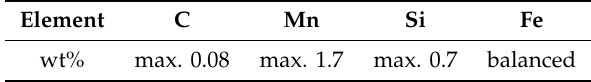
Table 3. Chemical composition for the filler material with E 50 4 B 4 2 H5.